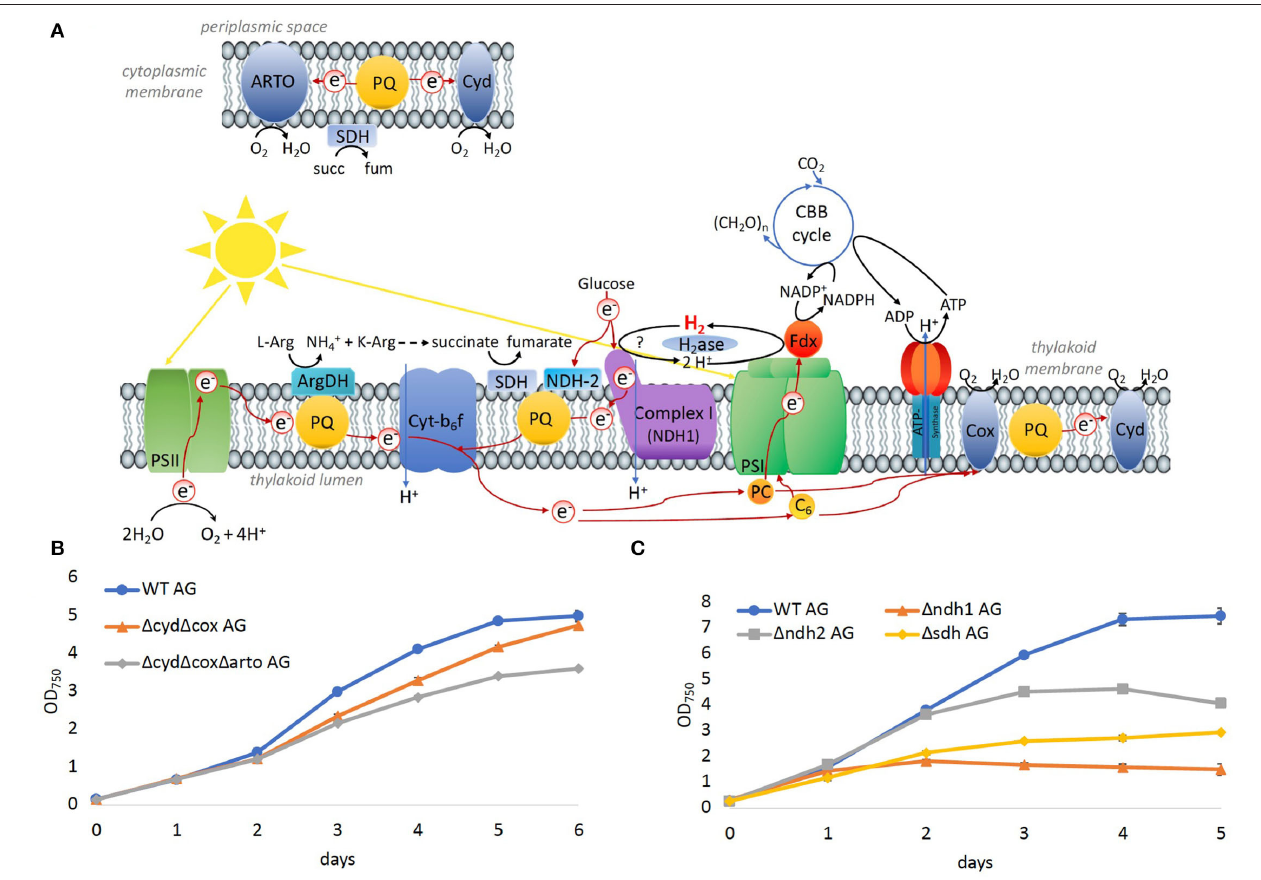
FIGURE 8 | Significance of the respiratory electron chain for growth on arginine and glucose. (A) Overview of photosynthetic and respiratory electrons chains in the thylakoid and cytoplasmic membrane. (B) Growth of WT and mutants in which terminal oxidases were deleted on arginine and glucose. (C) Growth of WT and dehydrogenases, that feed electrons into the PQ pool on arginine and